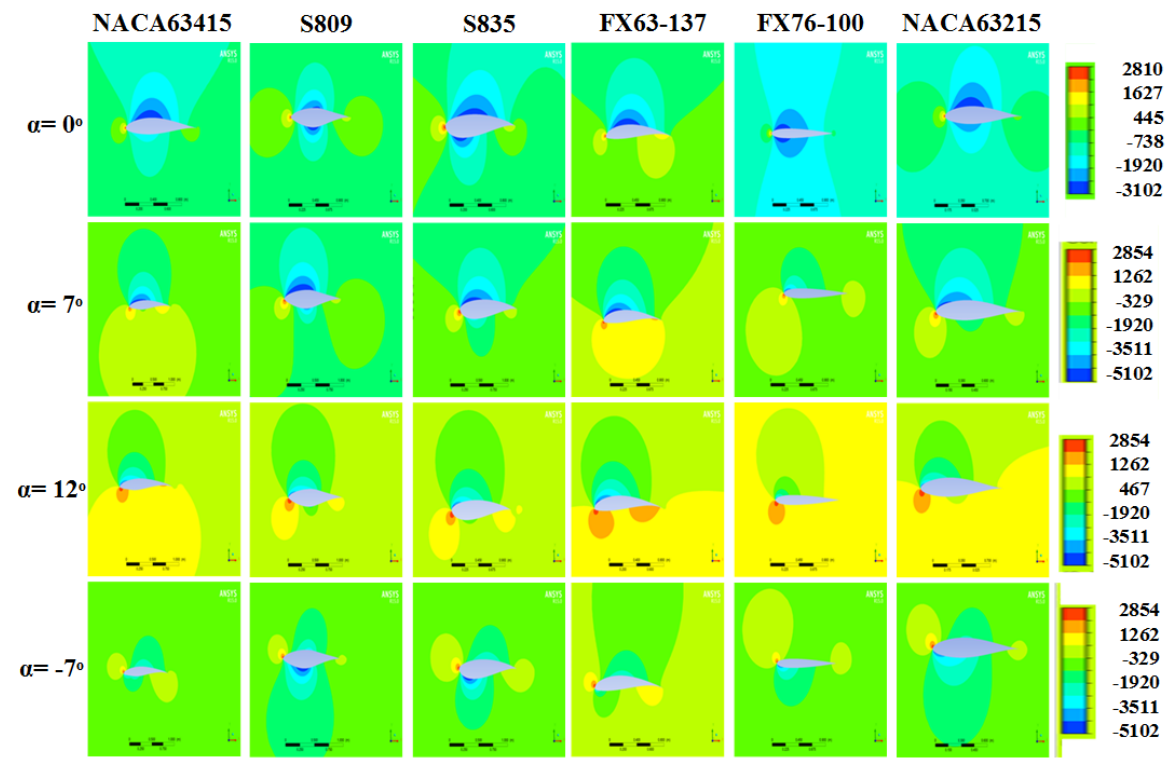
Figure 6. Pressure contour around airfoils.